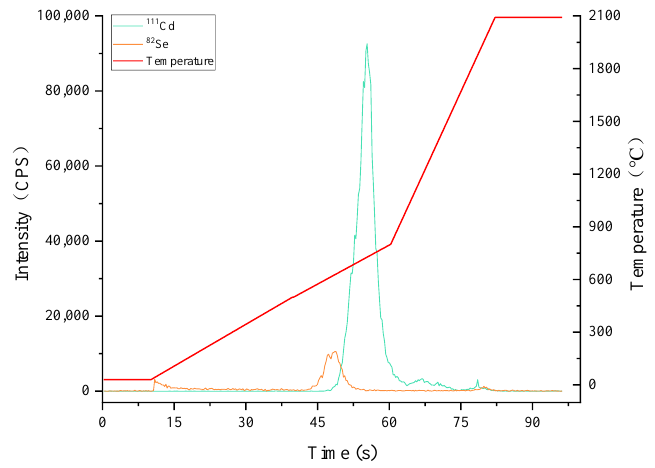
Figure 3. Cd and Se signal peaks with the increase of ETV heating time (temperature). The operating parameters of ETV monitoring are shown in Table S3. A rice sample (GBW10010a, Cd = 53 ± 4 ng · g − 1 and Se = 36 ± 8 ng · g − 1 ) was employed for slurry sampling.